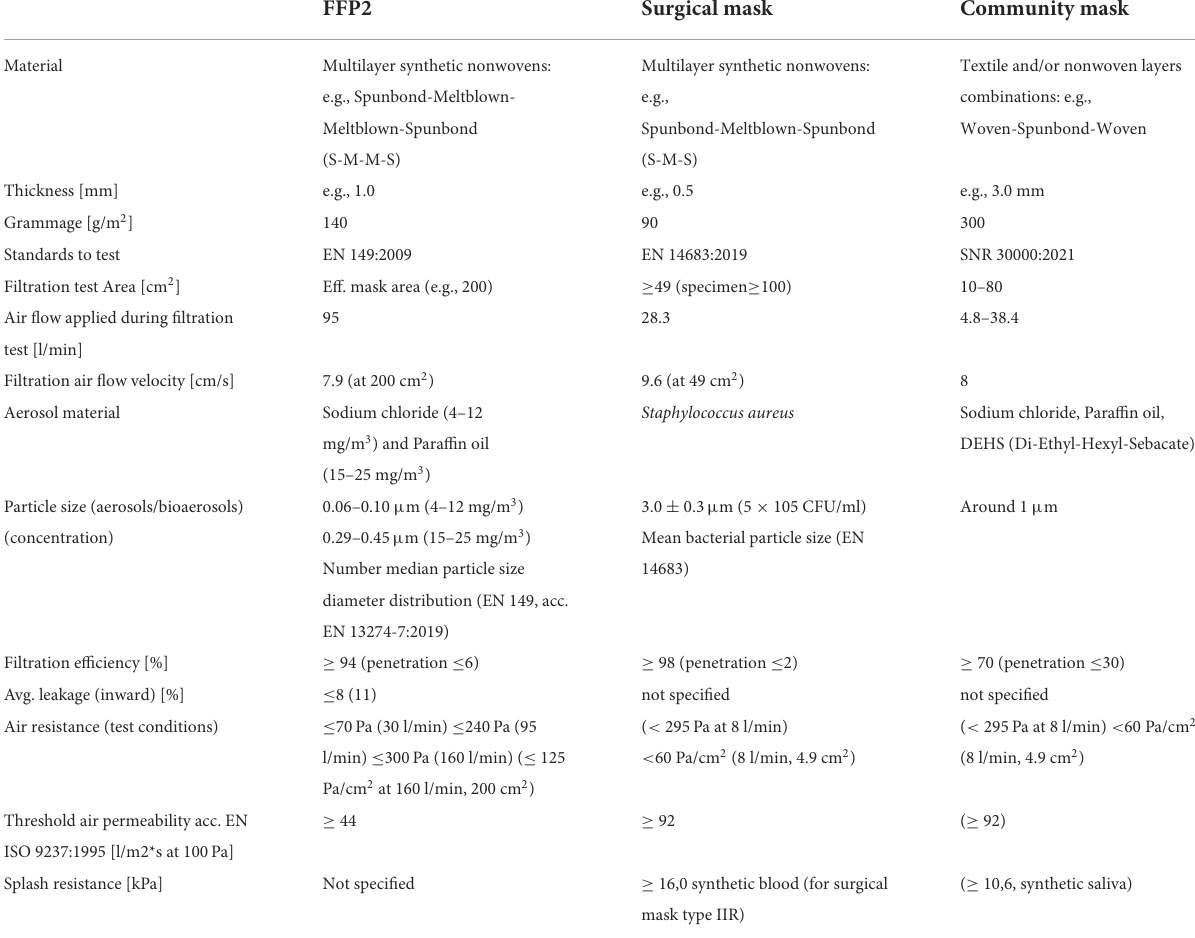
TABLE 2 Standards and characteristics of FFP2, surgical mask, and community mask. FFP2 Surgical mask Community